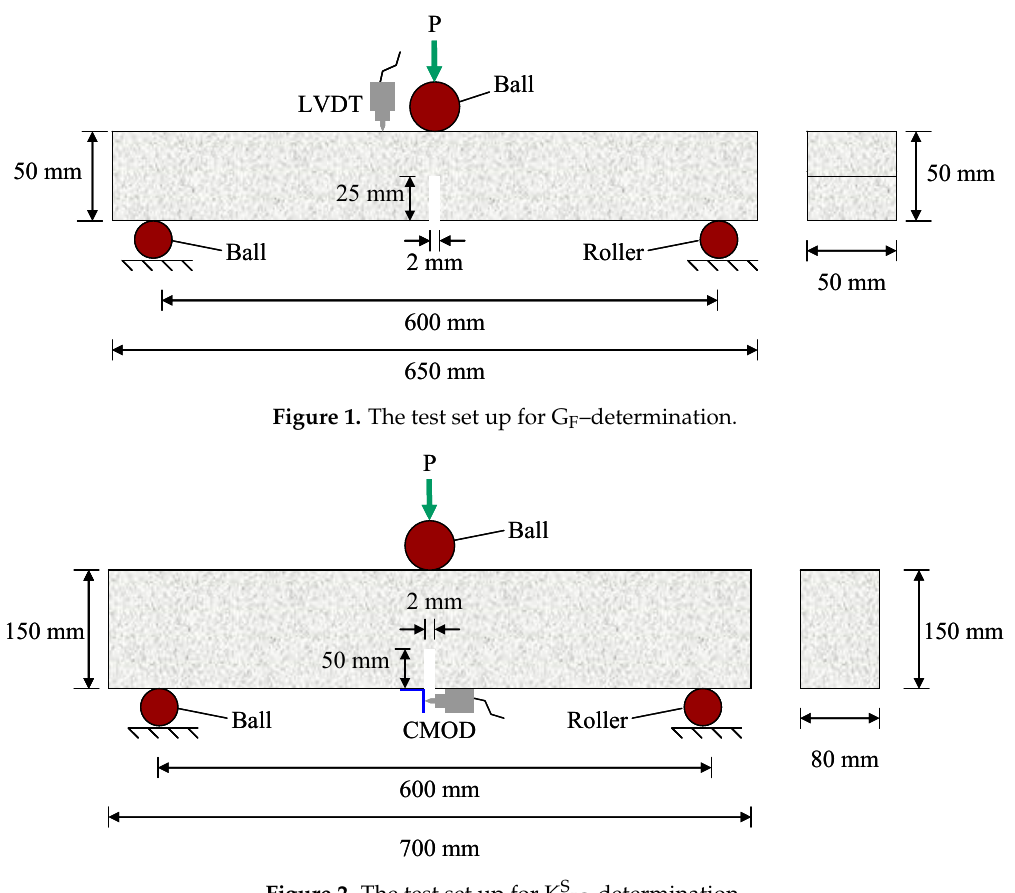
Figure 2. The test set up for K SIC -determination.